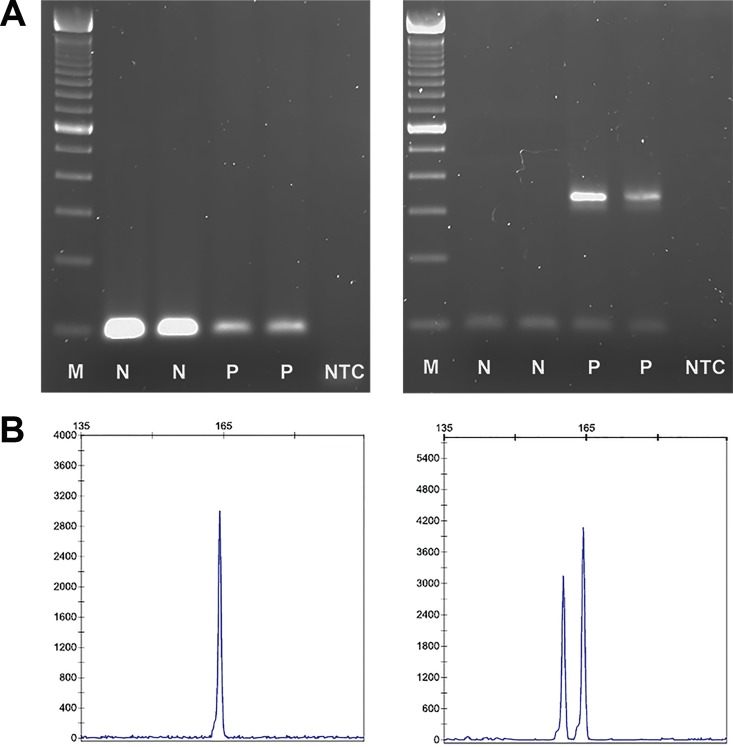
Detection of the BRCA2 c.156_157insAlu mutation and the BRCA1 c.3331_3334del mutation in FFPE tissue.(A) Gel electrophoresis pattern of amplification of BRCA2 exon 3 (left panel) and nested PCR specific for the BRCA2 c.156_157insAlu mutation (right panel). In non-carriers of the mutation (N) only one amplicon is expected, whereas in carriers (P) a second amplicon is visible in the nested PCR. Non template control (NTC) and 100 bp DNA standard (M) also shown. (B) Capillary electrophoresis pattern from a negative sample (left panel) and a positive control of the BRCA1 c.3331_3334del mutation (right panel) showing one peak (wild-type alleles) and two peaks (wild-type and mutant allele with 4 bp deletion), respectively.